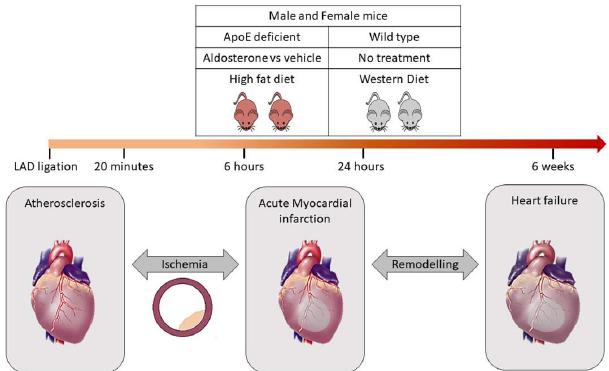
Figure 2. Validation of bioinformatics derived biomarker signature through mice model. The ApoE knockout mice subjected to high fat diet under the influence of aldosterone or vehicle will be compared to wildtype mice subjected to western diet. LAD ligation is performed for both ApoE- / - and wildtype mice for di ff erent time periods such as 20 min, 6 h, 24 h and 6 weeks. This will help to distinguish the signature specific for ischemia prior to MI